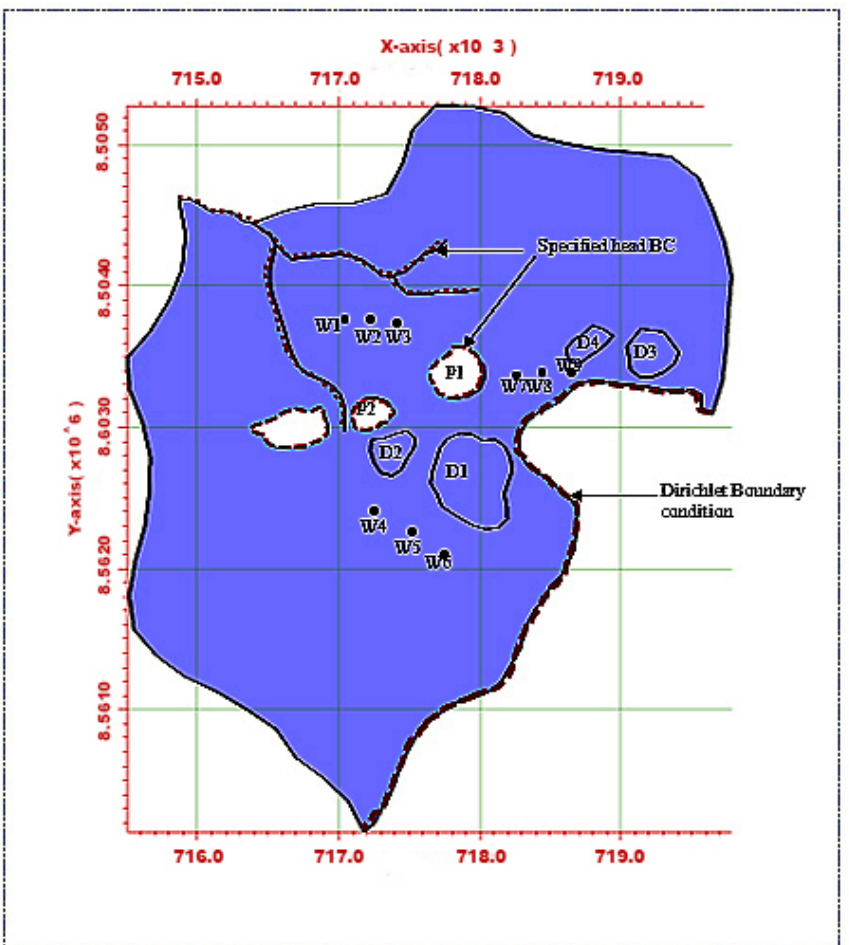
Figure 7. Mine site aquifer with four contaminated waste rock disposal sites and nine observa- tion